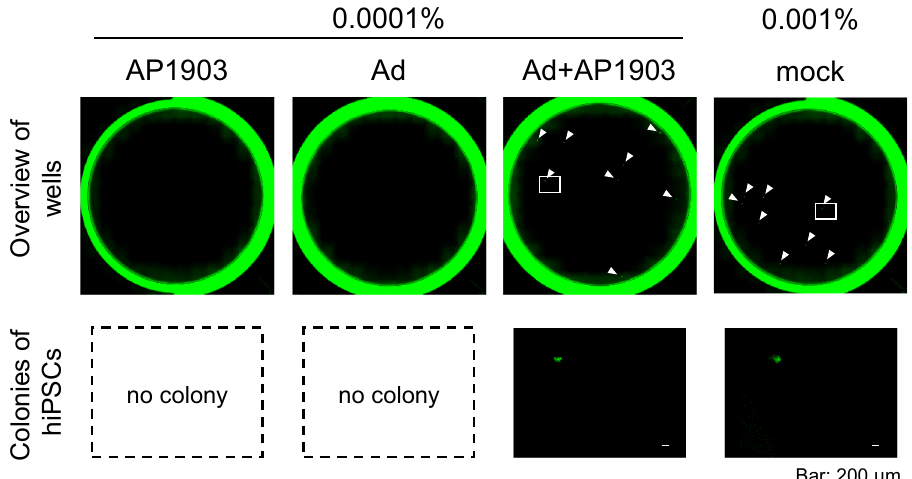
Figure 3. HEC assay for a trace amount of hiPSCs in cultures of immortalized NPCs after treatment with the Ad vector and AP1903. Immortalized NPCs supplemented with hiPSCs at a ratio of 0.0001% or 0.001% as a positive control were treated with the Ad vector (3 pfu/cell) and AP1903. After treatment, the cells were harvested and seeded onto laminin-521-coated 12-well plates (1–2 wells per sample). Four days after seeding, cells were immunostained with an anti-TRA-1-60 antibody. The lower panels are images, which correspond to the squares in the upper panels. The arrowheads indicate hiPSC colonies. Representative images of three independent experiments are shown. Scale bar is 200 µm.